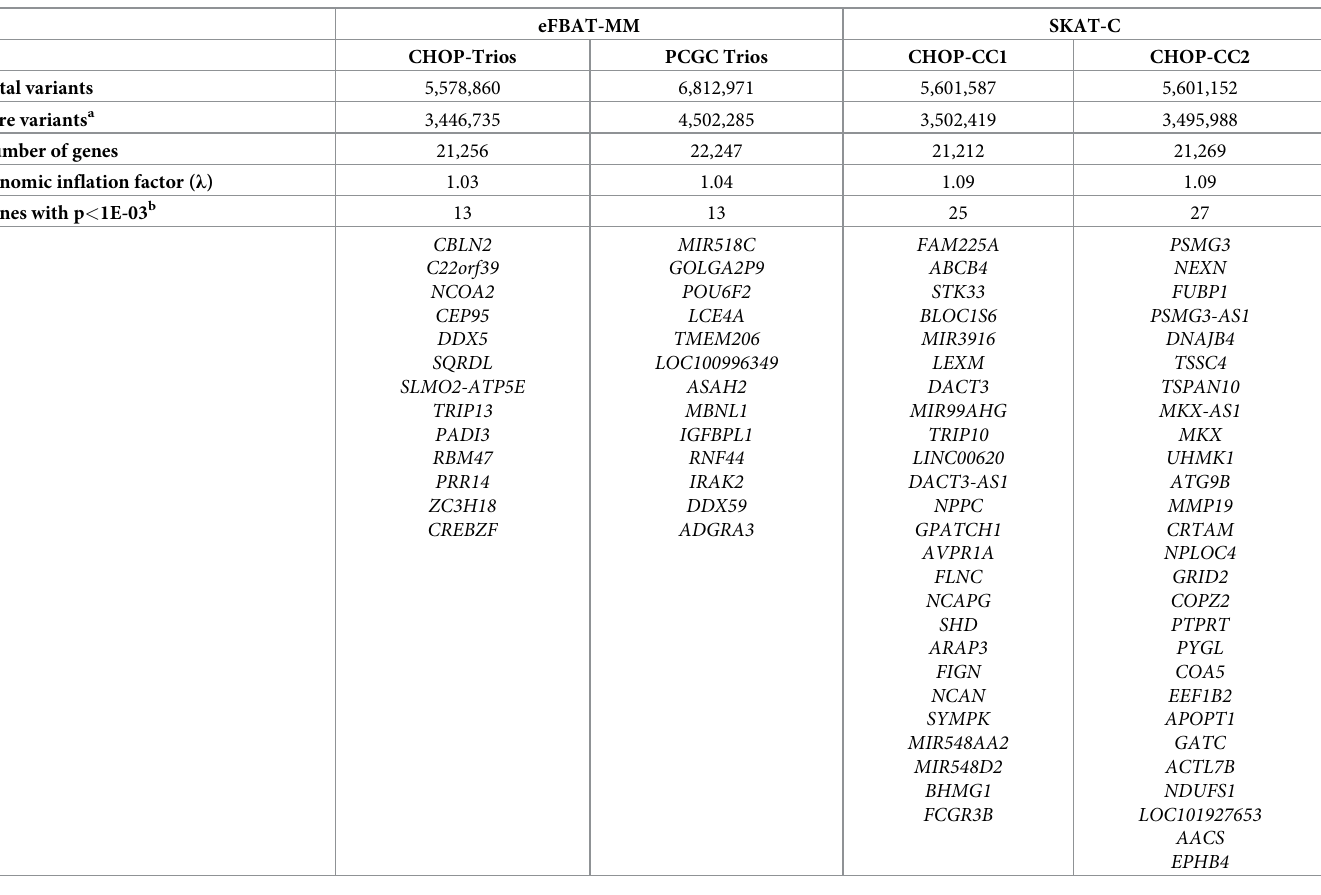
Table 2. Summary of eFBAT-MM and SKAT-C analyses and